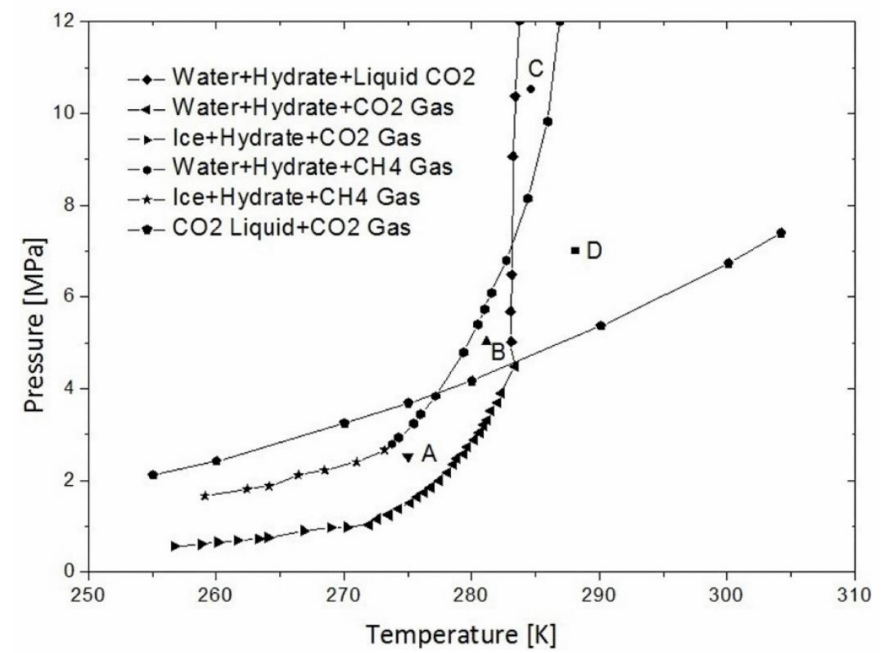
Figure 5. CH 4 -CO 2 -H 2 O phase equilibrium diagram. Areas A, B, C and D indicate the possibility of phase changes for CO 2 and CH 4 hydrates which are affected by temperature and pressure